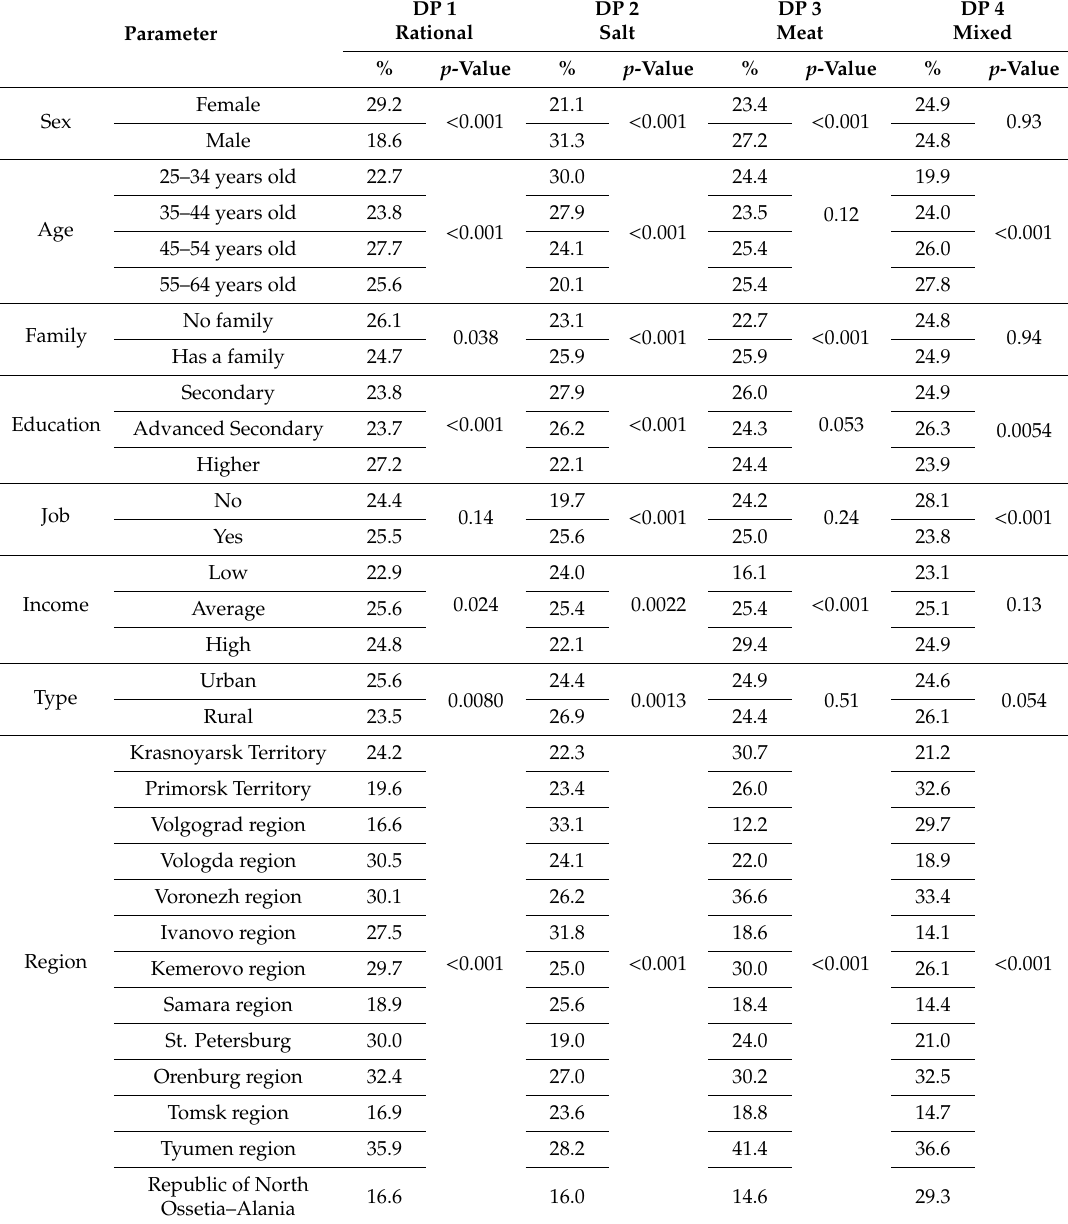
Table 4. Bivariate associations of socioeconomic, demographic, and regional variables with the dietary